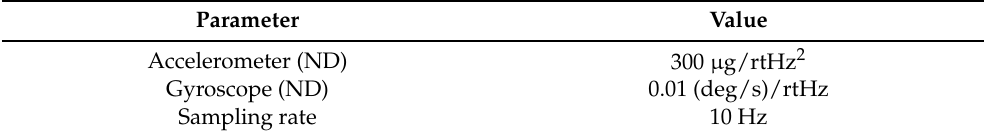
Table 5. IMU sensor specifications.